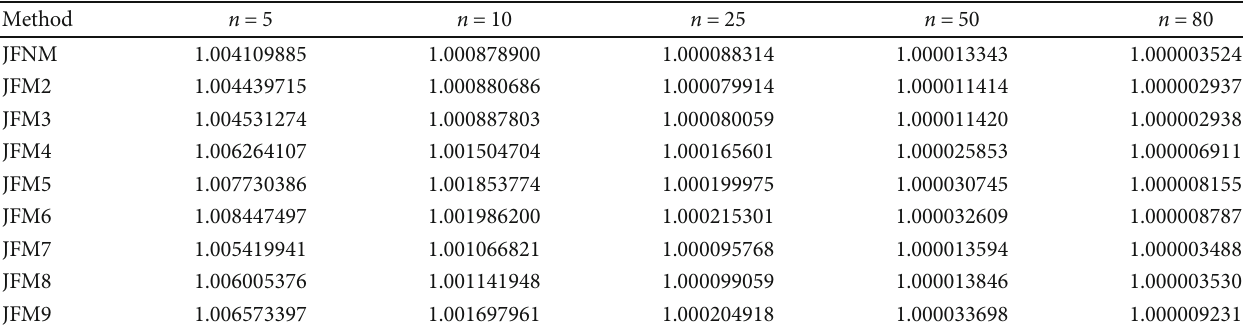
Table 28: Results of CEI for the methods in the second category to solve Test Problem 1, and n = 5,10,25,50,80 .